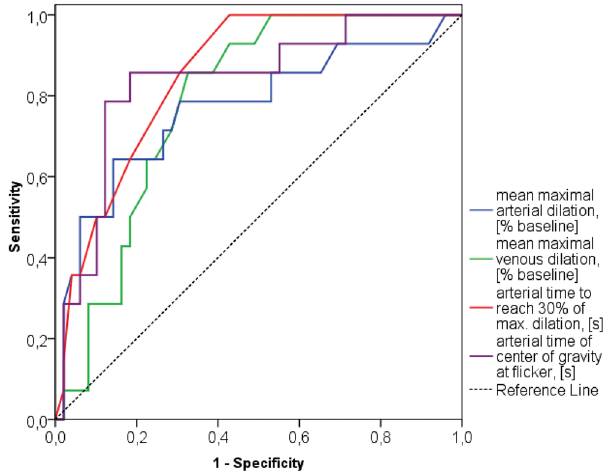
Figure 5. ROC-curves to reveal ADD for some parameters of the study [AUC (95% CI)]: mean maximal arterial dilation: AUC = 0.770 (0.613; 0.927), p = 0.003; mean maximal venous dilation: AUC = 0.786 (0.674; 0.898), p = 0.002; arterial time to reach 30% of max. dilation: AUC = 0.853 (0.758; 0.947), p < 0.001; arterial time of center of gravity at flicker: AUC = 0.837 (0.714; 0.959), p <